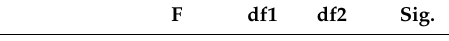
Table 7. Results of Levene’s test for equality of variances (type of course).